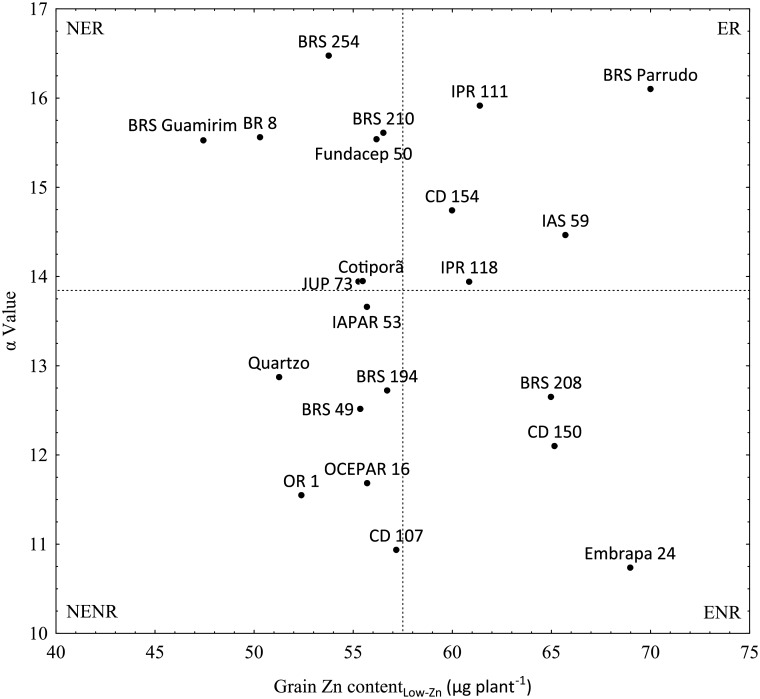
Classification of 22 winter wheat genotypes based on the relationship between grain Zn content (Low-Zn = no Zn added in the soil) and the α value for grain Zn content calculated between applications of 0 and 5 mg Zn dm-3 [35].The solid lines represent the mean value for the axis. NER = non-efficient and responsive genotypes, ER = efficient and responsive genotypes, NENR = non-efficient and non-responsive genotypes and ENR = efficient and non-responsive genotypes. Values represent the mean of four independent replicates.